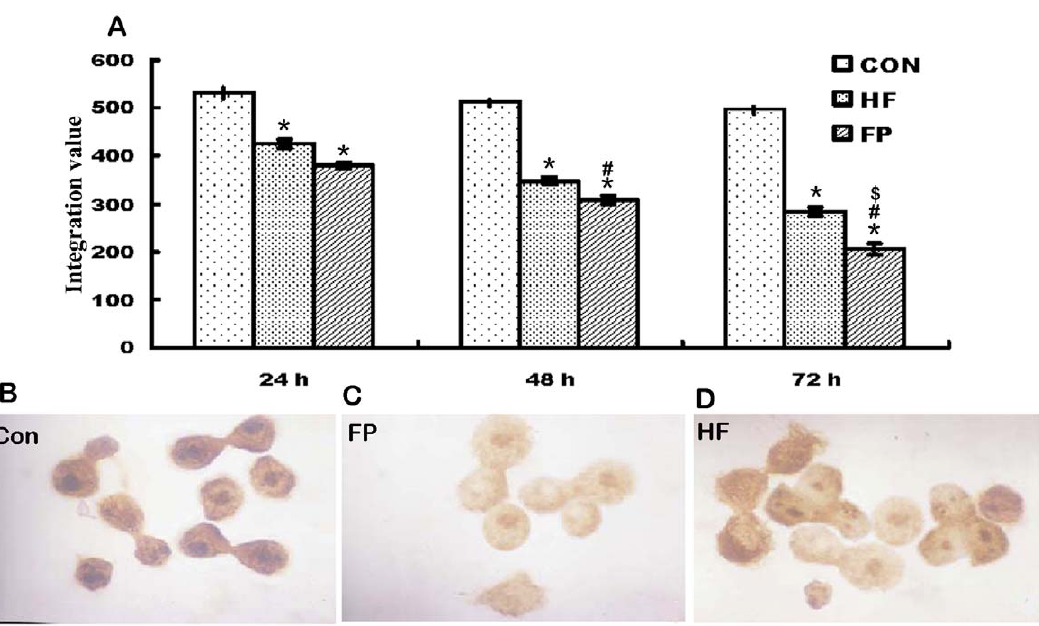
Figure 4. PCNA-immunoreactivity (IR) was detected by brownish staining in HeLa cells after treatment for 48 h, 1,000 6 . A) PCNA-IR integration values (IV) of each group after treatment for 24, 48 and 72 h were analyzed as described in Materials and Methods. B) PCNA-IR was localized in the nuclei in the control group. C) PCNA-IR was attenuated in the FP group. D) PCNA-IR was attenuated and inactive PCNA-IR was also located in the cytoplasm in the HF group. Values are given as means 6 SE. * p , 0.001 versus control cells; # p , 0.01 versus HF group; $ p , 0.01 versus